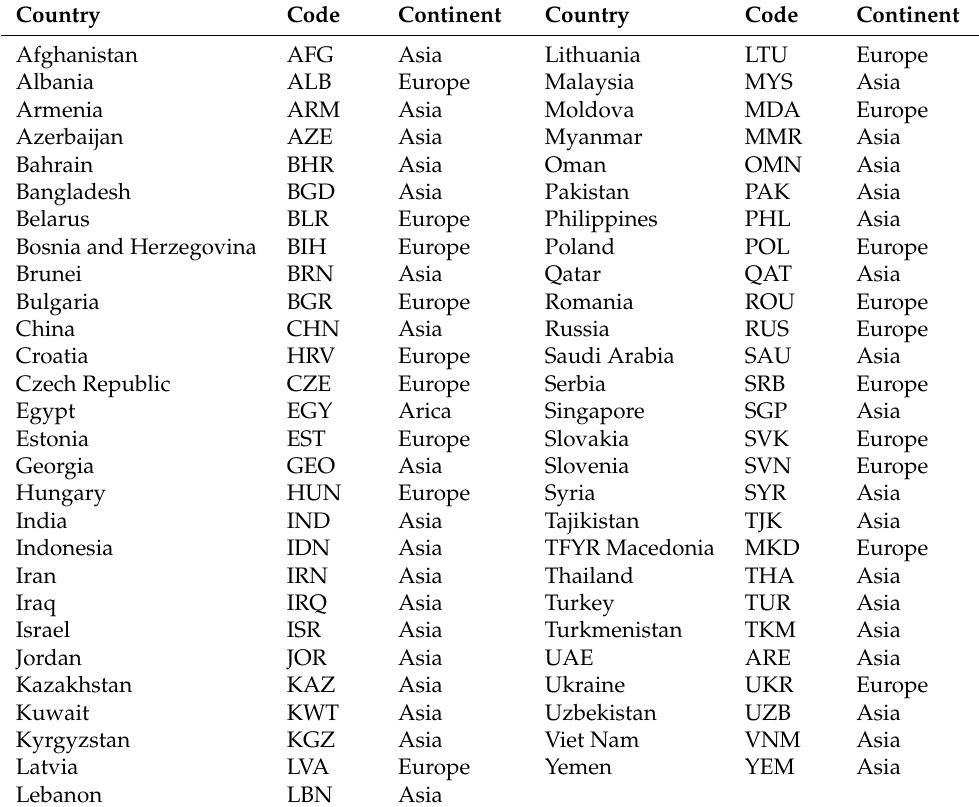
Table A1. Countries, codes, and